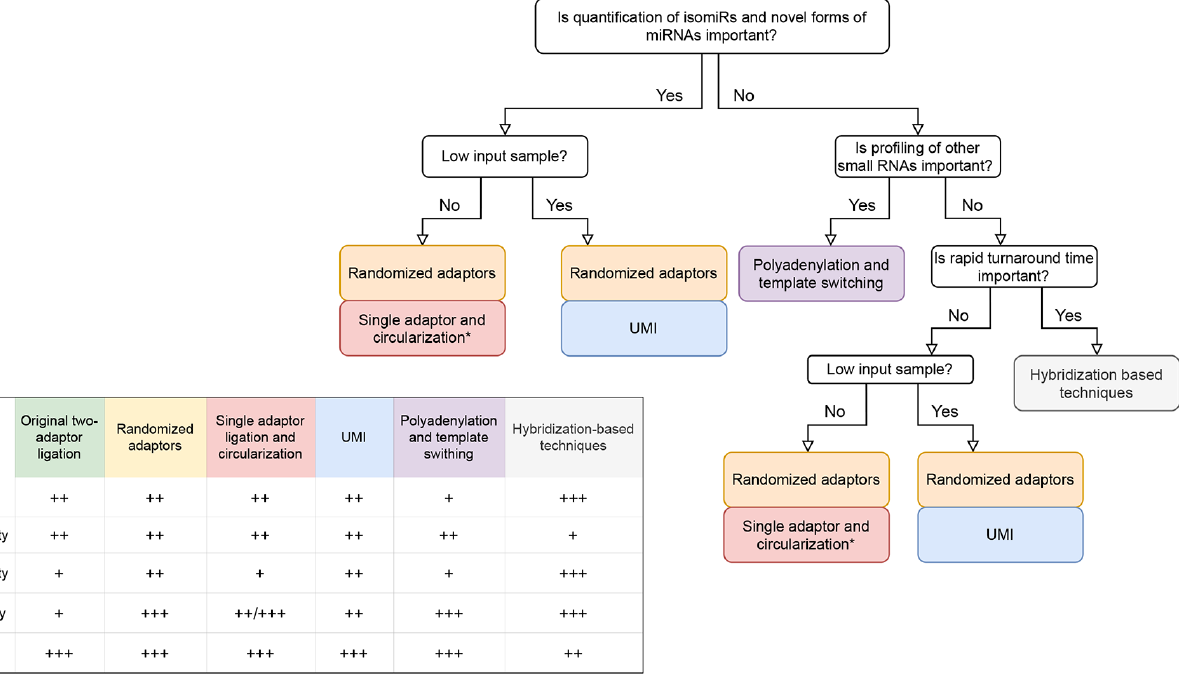
Figure 4. Selection of platform for small RNA-seq analysis. Decision diagram guides an informed choice of suitable protocol. Of note, other non-depicted experiment-specific criteria need to be further considered. Performance metrics represent a consensus of recent benchmarking studies listed in Table 2. +; poor, ++; average, +++; good, DEGs; Differential expression, *; Somagenics RealSeaq-AC